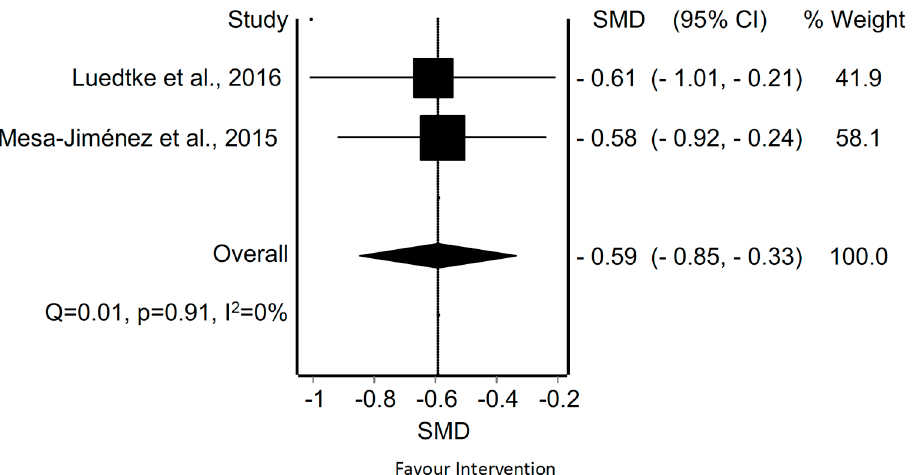
Figure 7. Synthesis forest plot for pain intensity in patients with tension-type headache and mixed intervention (manual therapy and/or therapeutic exercise). The forest plot summarizes the results of included studies (review size, standardized mean differences [SMDs] and weight). The small boxes with the squares represent the point estimate of the effect size and sample size. The lines on either side of the box represent a 95% confidence interval (CI).